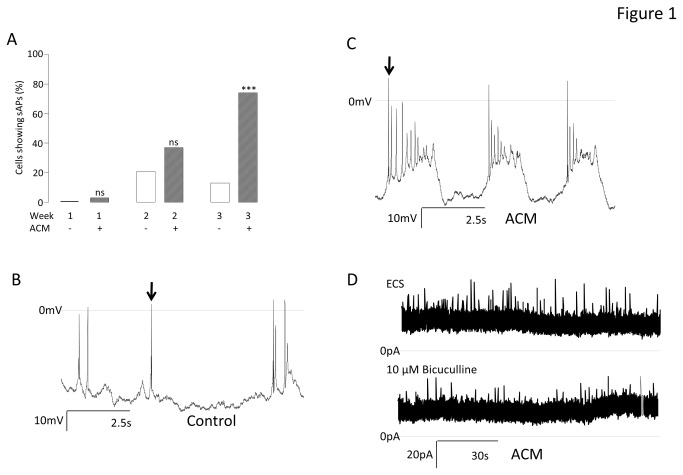
Effect of ACM on the development of spontaneous activity.A. A bar graph showing the proportion of cells (%) at each week which fired sAPs during current-clamp (I = 0 pA) at the native membrane potential (Vm). Chi2 tests were performed at each week to compare control (ACM-) and ACM-treated (ACM+) iPS-derived neurons. ***P < 0.0001, nsnot significant; n = 147 .B. Exemplar current-clamp recording (I = 0) from a neuron differentiated for 3 weeks in control medium. Arrow indicates example action potential.C. Typical current-clamp recording (I = 0) from a neuron differentiated for 3 weeks in ACM. Arrow indicates first action potential in a spontaneous train.D. Example current recording during voltage-clamp (Vh = -20mV) showing tetrodotoxin-insensitive spontaneous miniature inwards currents in cells differentiated for 3 weeks in ACM in absence (upper trace) and presence (lower trace) of GABAA receptor blockade with10 μM bicuculline.